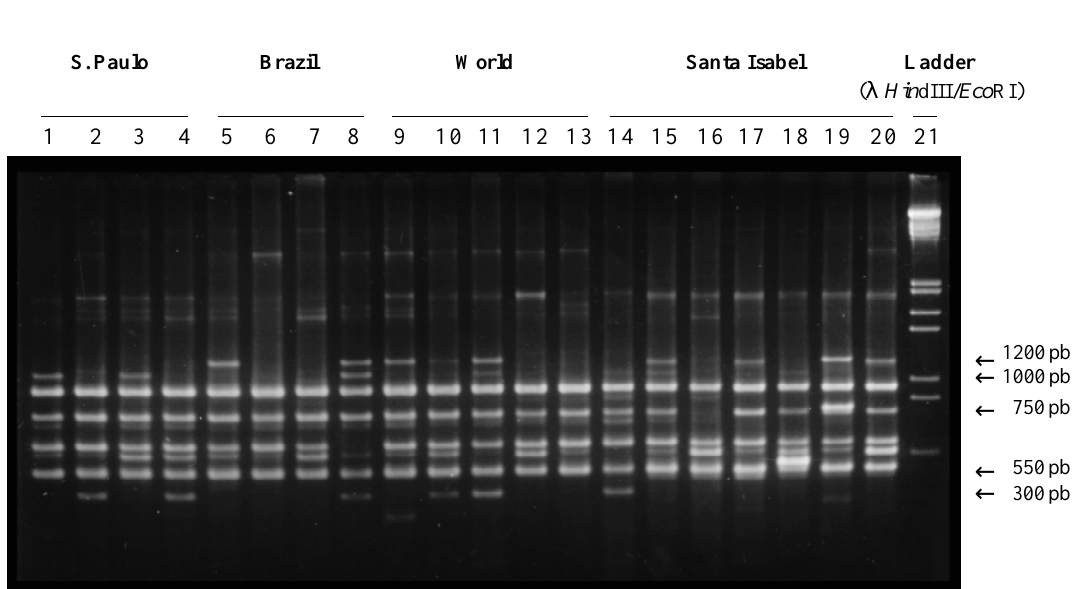
Figure 1 - Example of cassava RAPD amplification (primer N20 Operon) in agarose gel 1.8%. Only the clearly amplified polymorphic bright bands were analyzed (arrows signal the length of these fragments in pairs of bases). The faint bands were not